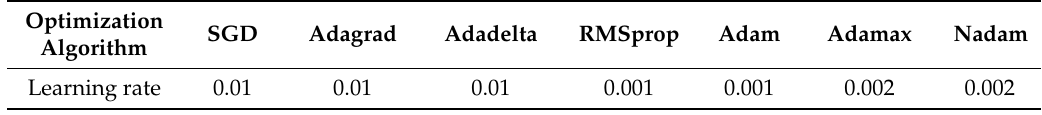
Table 2. The learning rate of each optimizer method for training the CNN models.